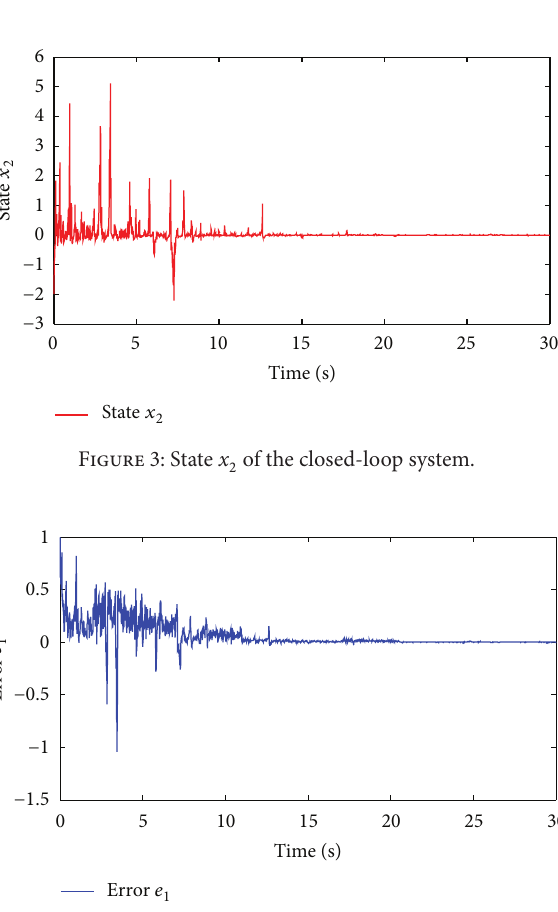
Figure 4: The estimated error e 1 .